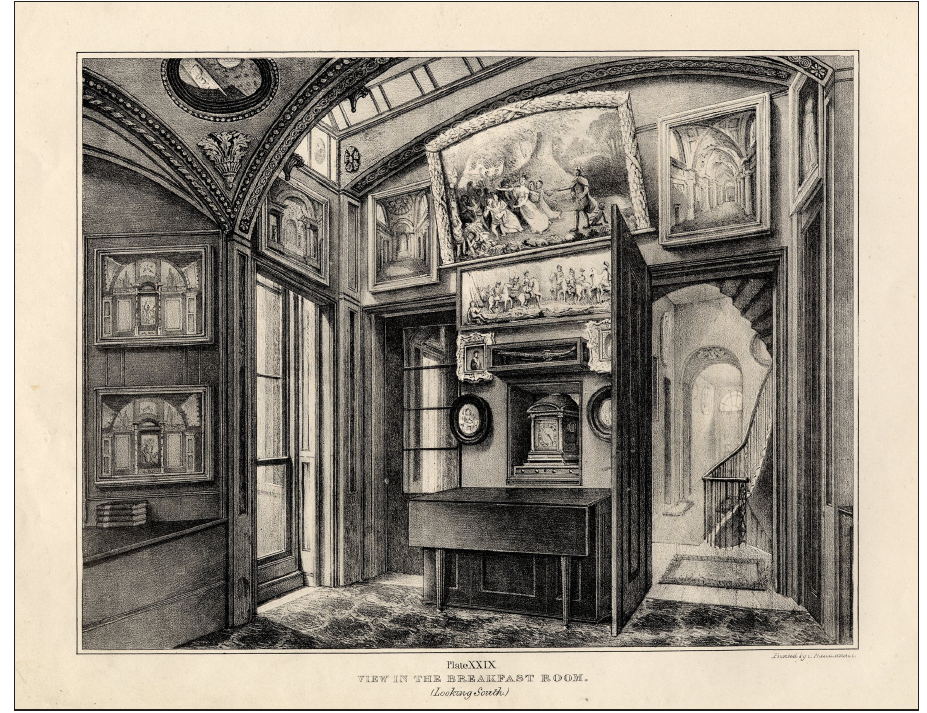
Fig. 5 : View of the breakfast room at 13 Lincoln’s Inn Fields from Sir John Soane’s 1835 Description of the House and Museum , plate